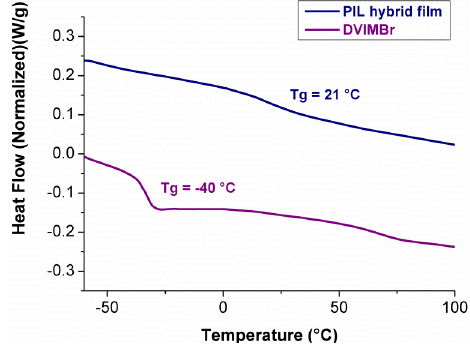
Figure 6. DSC thermogram showing the glass transition temperature, T g of PIL hybrid film and DVIMBr.